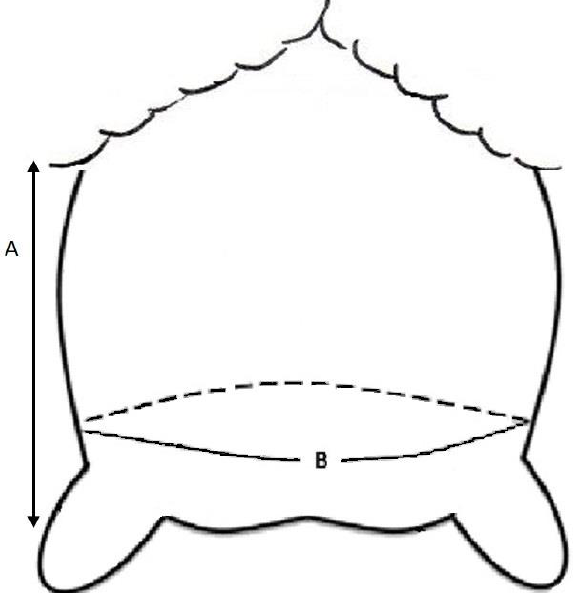
Figure 2. Morphological traits of yearling ewe udder. A. Udder height (cm) measured from outside edge of the udder between the ewe leg and the udder floor; B. Udder circumference (cm) taken above the teats (adapted from [24] ).